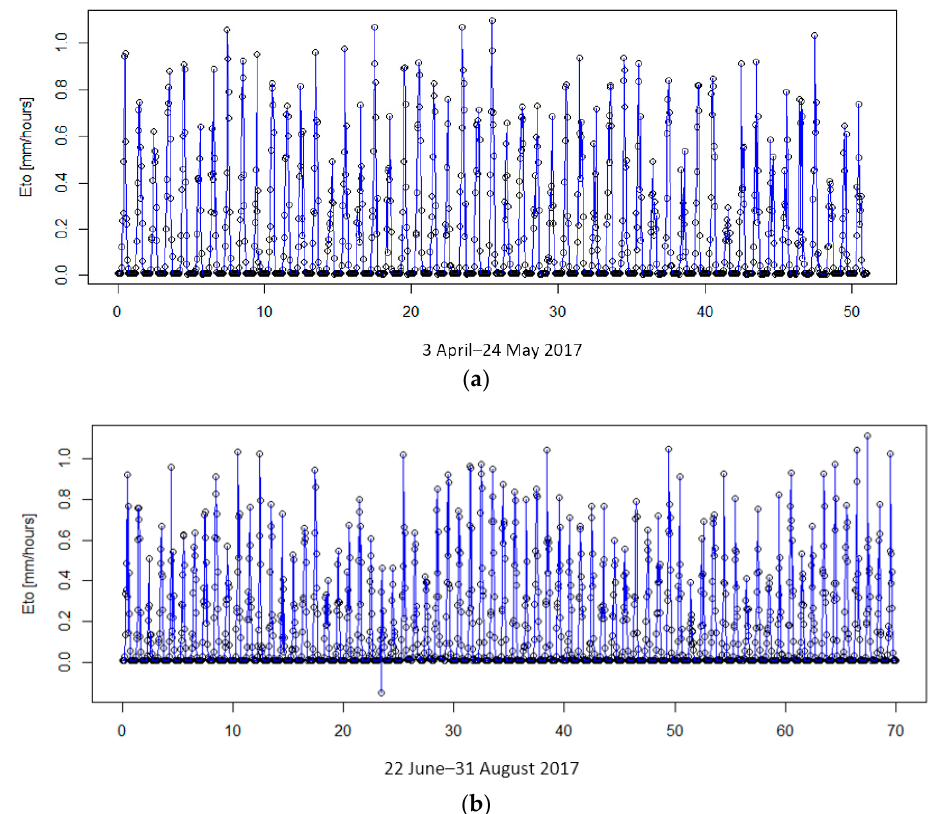
Figure 1. The reference evapotranspiration (ETo) (mm/hour) of the oil palm plantation area in Pundu, Central Kalimantan, during ( a ) April–May 2017, ( b ) June–August 2017.